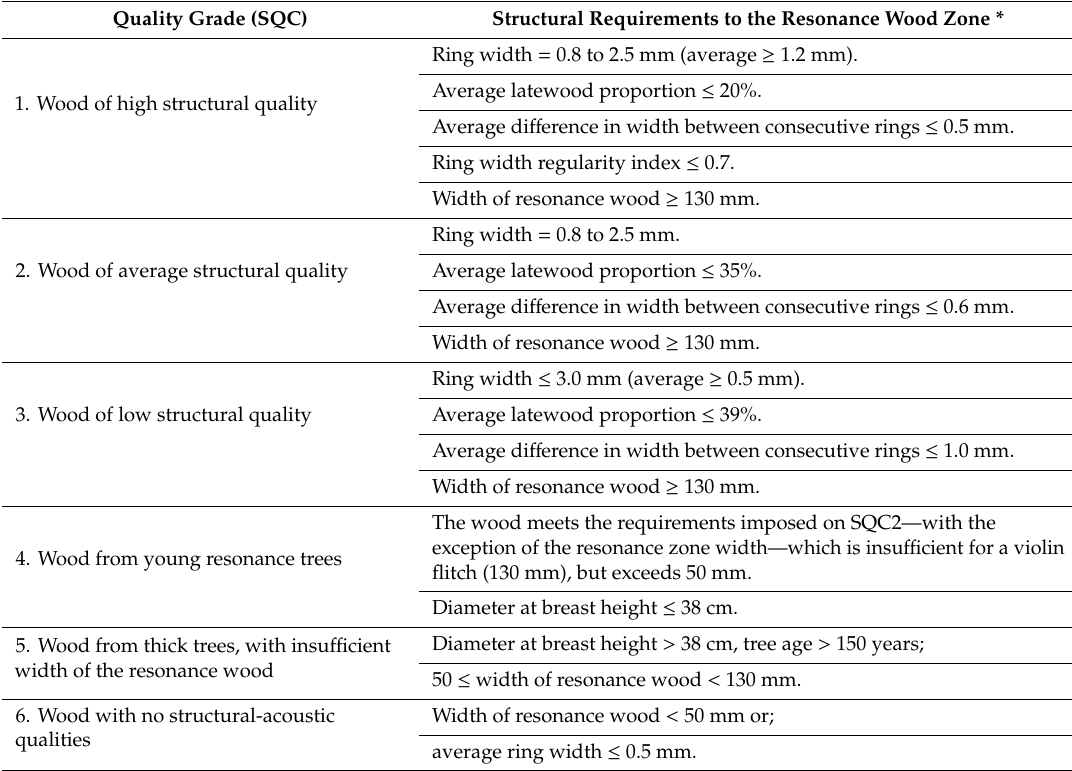
Table 2. The structural-qualitative classification of raw material intended for violin making [4]. Quality Grade (SQC) Structural Requirements to the Resonance Wood Zone